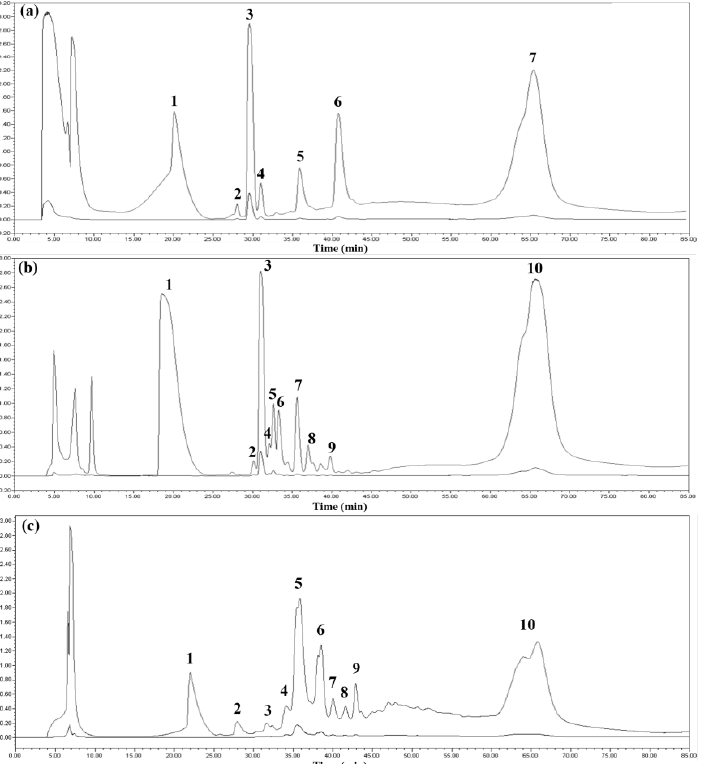
Figure 2. HPLC chromatograms of tIK peptides. ( a ) tIK-9mer, ( b ) tIK-14mer, and ( c ) tIK-18mer. Each peptide was purified using reverse-phased semi-prep HPLC, and all peaks except the flow through were recovered. peaks with the highest intensity (peak 3 for 9mer and 14mer; peak 5 for 18mer) were assumed to be purified protein. (Peak 7 of (a) and peak 10 of (b) and (c) are KSI fragments, and the other peaks are impurities.)